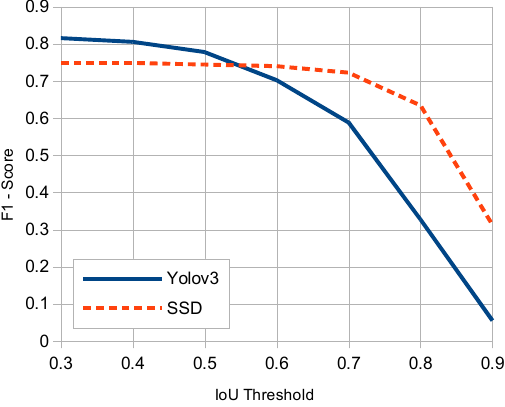
Figure 8. Average F1-score vs. IoU threshold comparison between SSD and YOLOv3.